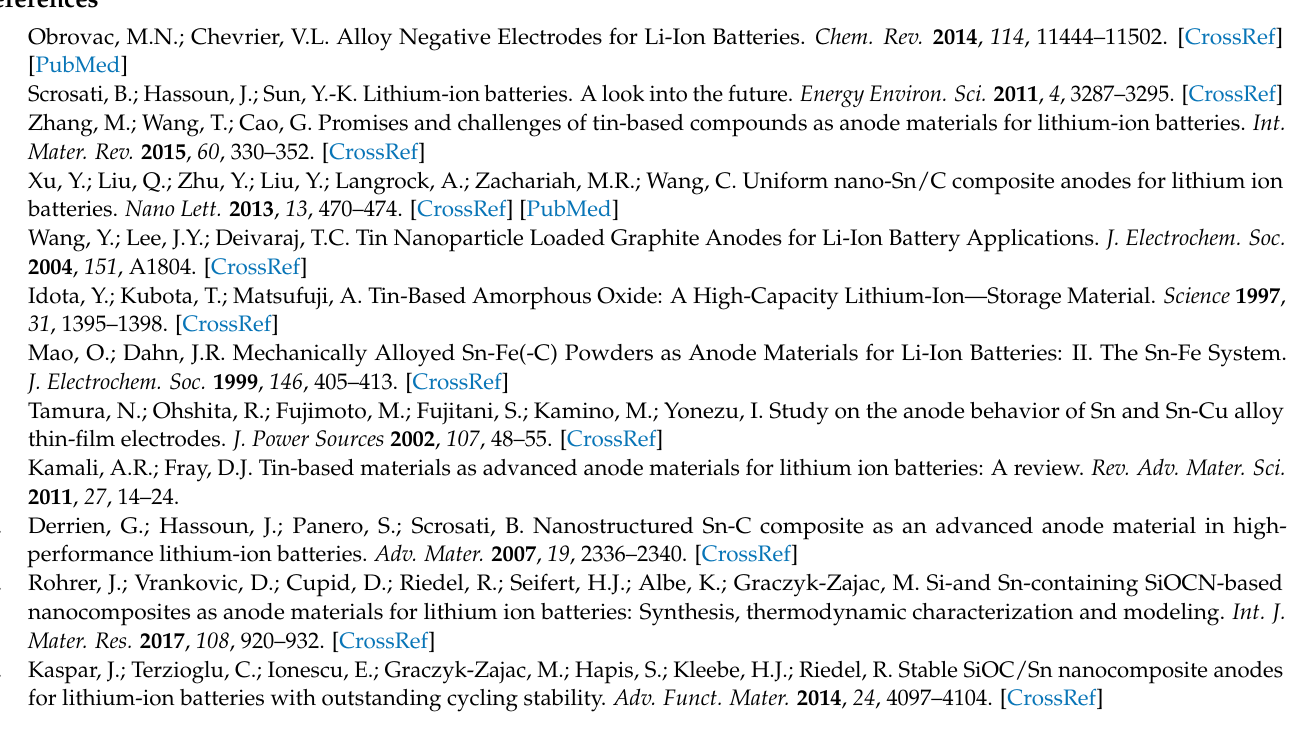
Figure S7. SEM images of (a) SiOC:C 0.2 /Sn-40% and (b) SiOC:C 0.1 /Sn-60% composites showing accumulation of tin nanoparticles in the ceramic phase.; Figure S8. Cyclic voltammetry curves of (a) SiOC:C 0.2 /Sn-60%, (b) SiOC:C 0.1 /Sn-60% and c) SiOC:C 0.2 /Sn-40%.; Figure S9. SEM images of electrode layers before (”fresh”) and after extended cycling tests (2 cycles at 18.6 mA g -1 followed by 100 cycles at 372 mA g -1 ) recorded for a) SiOC/Sn-40%, (b) SiOC:C 0.2 /Sn-40% and (c) SiOC:C 0.2 /Sn- 60%.; Figure S10. Diffractograms of the cycled electrodes, Inset: the selected 2Theta range of the diffractogram of SiOC:C 0.2 /Sn-60%